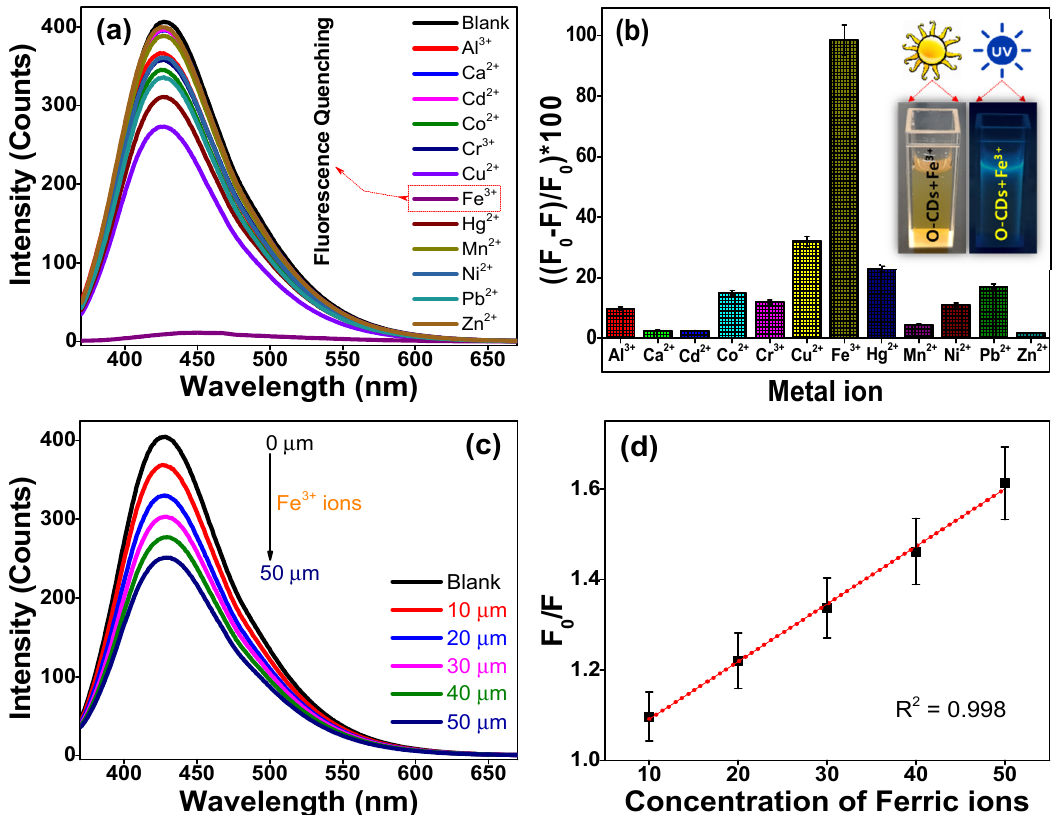
Figure 6. ( a ) Fluorescence response of the synthesized hydrophilic O -CDs in the presence of different metal ions (concentrations of metal ions are 1000 µM) and ( b ) corresponding relationship between ((F 0 -F)/F 0 )*100 and different metal ions (inset: photograph of O -CDs in the presence of Fe 3+ ions under normal (daylight) and UV light (365 nm)). ( c ) Fluorescence response of the synthesized hydrophilic O -CDs in the presence of ferric ions with different concentrations and ( d ) corresponding relationship between (F 0 /F) and the different concentrations of Fe 3+ ions. Table 1. Comparison of the different fluorescent sensors from natural sources for the selective sensing of ferric ions in water medium.